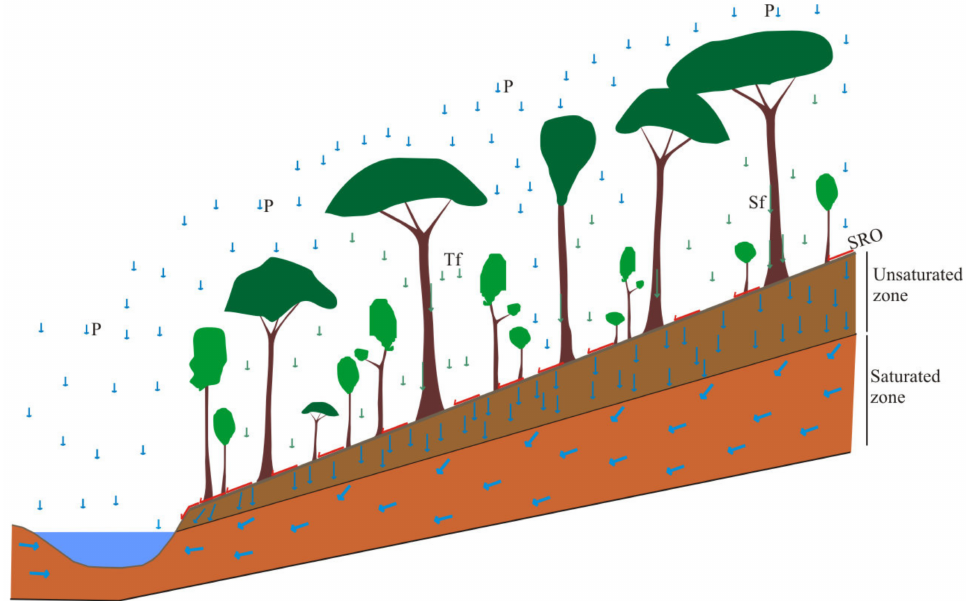
Figure 4. The process of water discharge in a forested catchment. (P = precipitation; Tf = throughfall; Sf = stemflow; SRO = surface